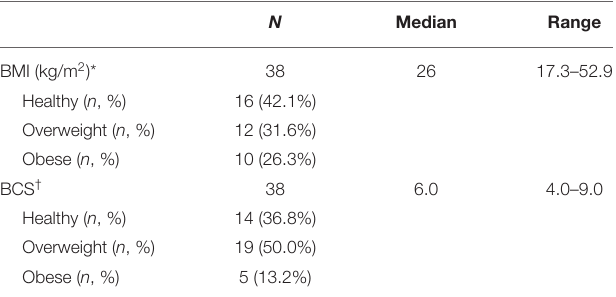
TABLE 1 | BMI of dog owners and BCS of dog study participants presented in median, range, and weight status. N Median